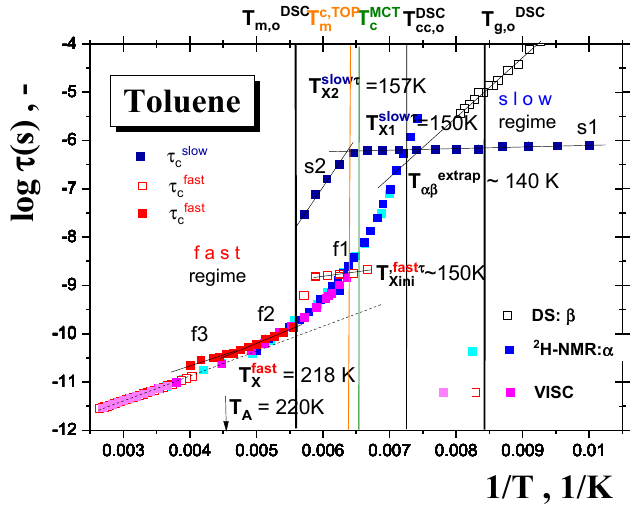
Figure 12. Comparison of the correlation times of TEMPO in the partially crystalline (below T mDSC ) and amorphous (above T mDSC ) spin probe TEMPO/TOL system with the time scales of the primary α – and secondary β relaxations in TOL from NMR [17–20] and VISC [51–53] data in the amorphous TOL medium.